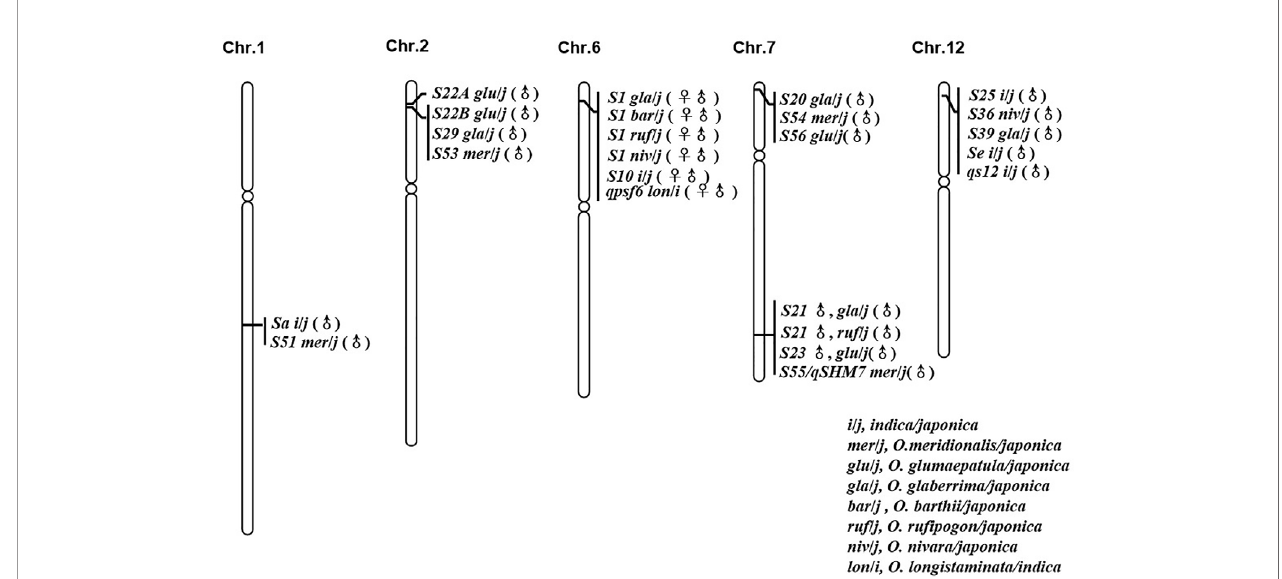
FIGURE 1 | Loci with good co-linear relationship and similar genetic action for hybrid sterility in